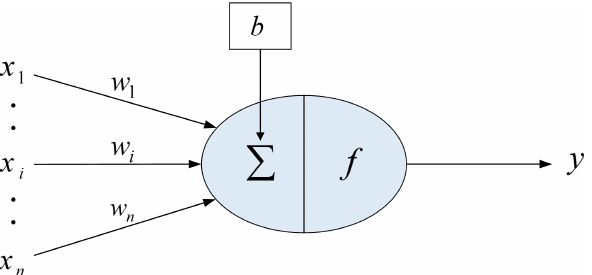
Figure 1. Neuron model, x i is the input signal, n is the number of signals, the weight value of the input signal is w i , bias is b and output of neurons is y